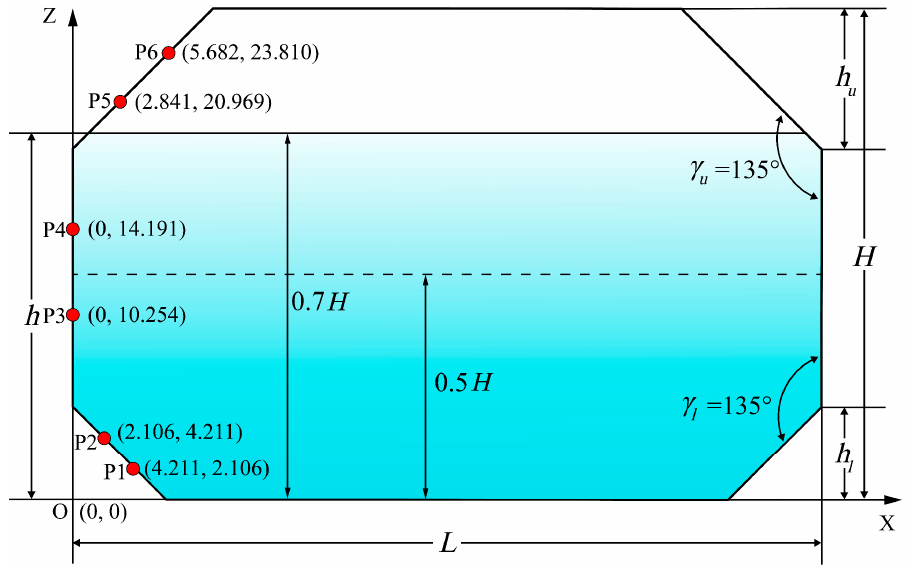
Figure 6. Diagram of the membrane-type tank and corresponding arrangements.